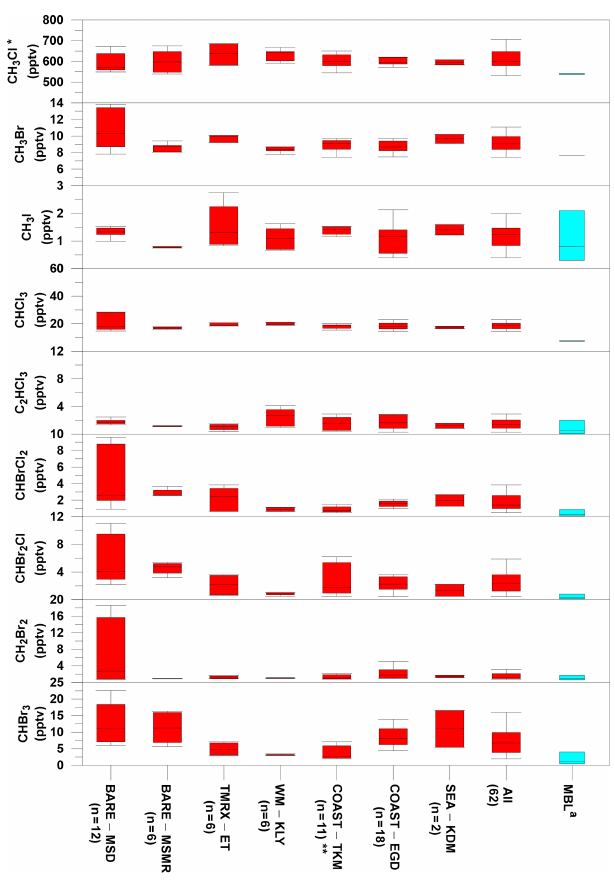
Figure 2. Comparison of VHOC mixing ratios (in pptv) measured at the Dead Sea with their corresponding values at the marine bound- ary layer (MBL). For the Dead Sea sites, boxes indicate median, upper and lower quartiles, and bars show minimum and maximum VHOC mixing ratios (see Table 1 for site abbreviations; n speci- fies the number of samples for each site). For the MBL, boxes in- dicate the median, minimum and maximum mixing ratios reported by Carpenter et al. (2014). a Values for CH 3 Cl and CH 3 Br rep- resent mean and range for 2012 based on flask measurements by the US National Oceanic and Atmospheric Administration (NOAA; http://www.esrl.noaa.gov/gmd/dv/site/, last access: 2019) and in situ measurements by the Advanced Global Atmospheric Gases Ex- periment (AGAGE; http://agage.eas.gatech.edu/, last access: 2019), which were performed at ground stations, not in all cases represent- ing the MBL. ∗ Related CH 3 Cl measurement excludes one sample at TMRX–ET-1 (see Sect. 2.1.2). ∗∗ Related measurements exclude one sample for all VHOCs (see Sect.